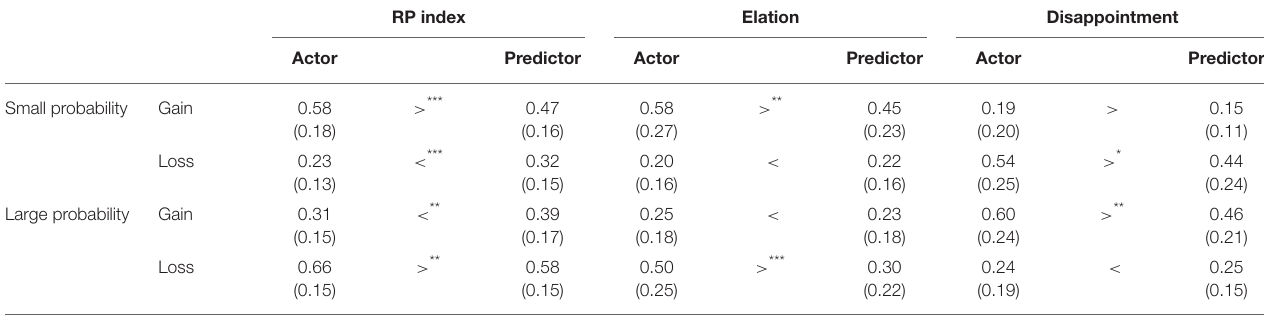
TABLE 1 | Mean ( ± SD ) RP index and anticipated